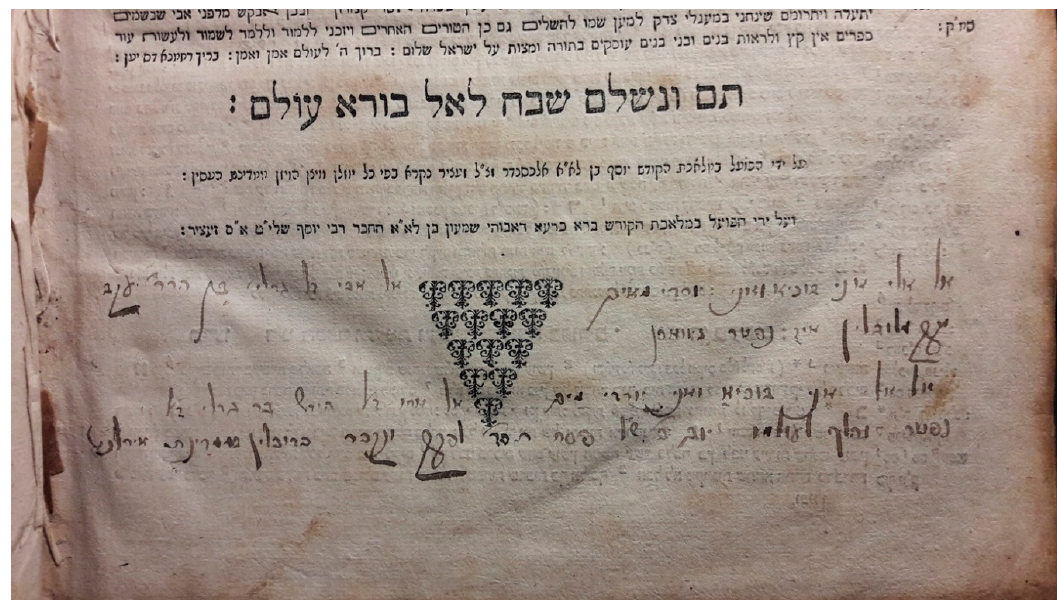
Figure 34. Sefer olat tamid, with reference to Dublin, Ireland; Marsh’s Library C.3.1.18. Photo courtesy of Dr Javier del Barco.